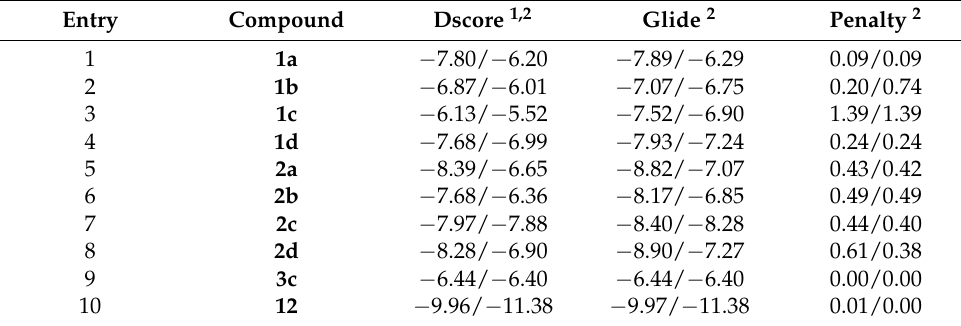
Table 1. Scores for docking of compounds 1a – d , 2a – d , 3c , and 12 to Pf